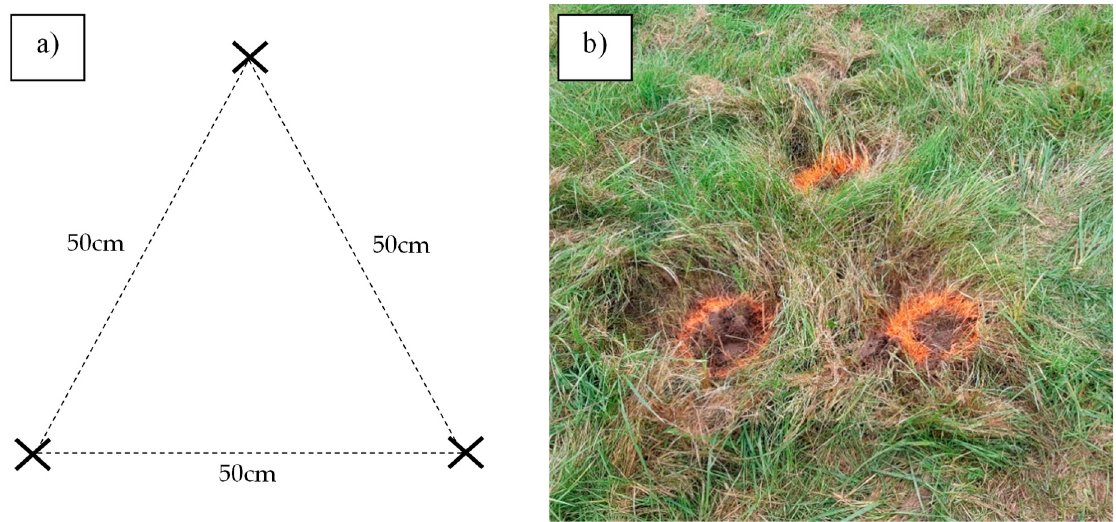
Figure 3. ( a ) Diagram of MDI measurement locations at the controls sample site. Black crosses (X) indicate MDI measurement location. ( b ) MDI measurement locations represented at the control sample site. Table 1. Soil percentiles and texture classification of each sample